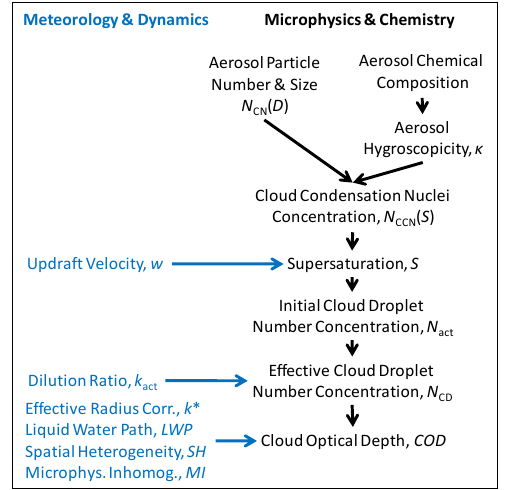
Fig. 21. Major processes and parameters contributing to the first indirect effect of aerosols on climate (Twomey